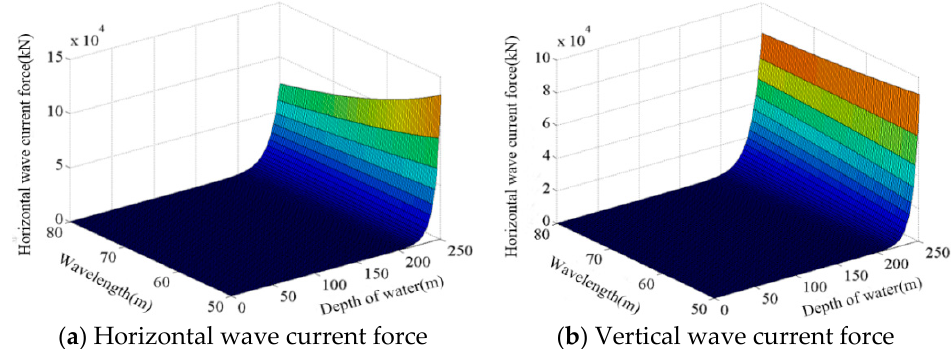
Figure 7. Variation of clamp wave flow force on vertical steel tube with wavelength and water depth.